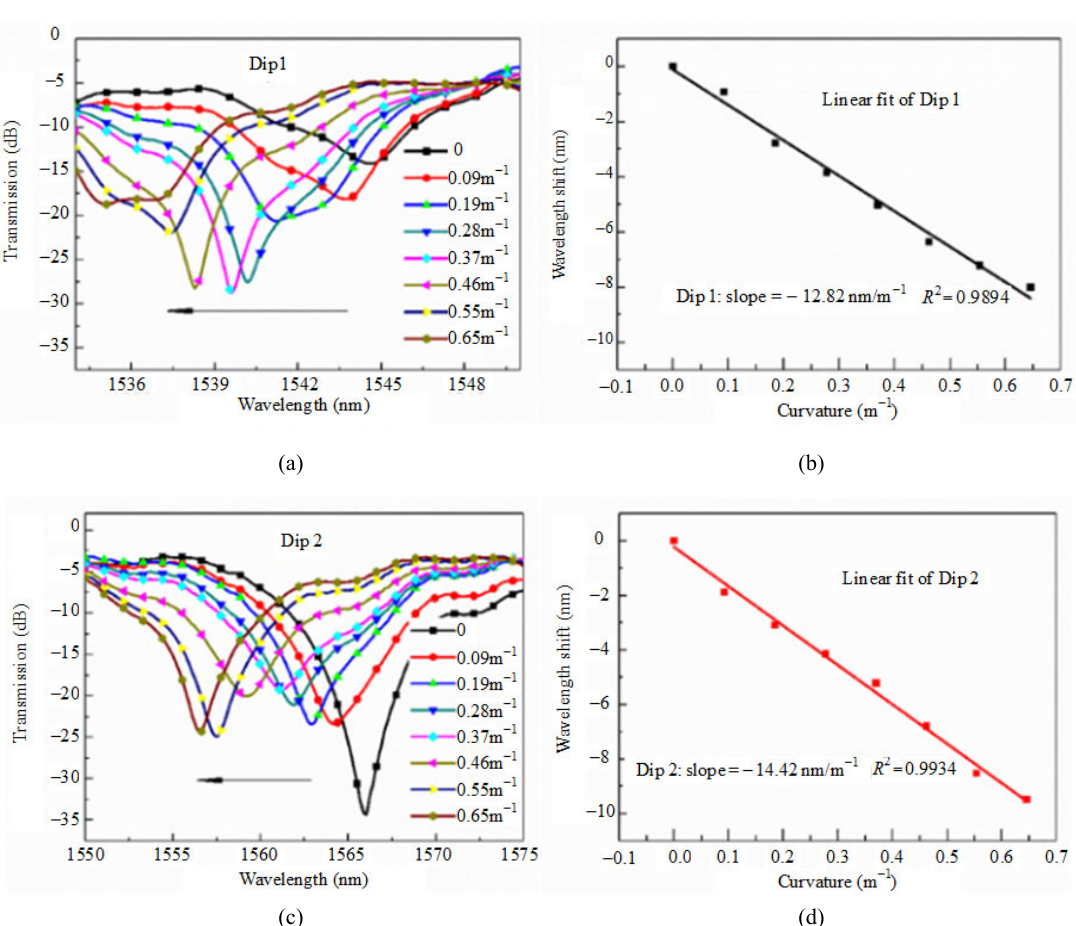
Fig. 7 Results of the curvature response experiment: (a) and (c) transmission spectrum change of the MZI as the curvature increases; (b) and (d) linear relationship between the curvature and the wavelength